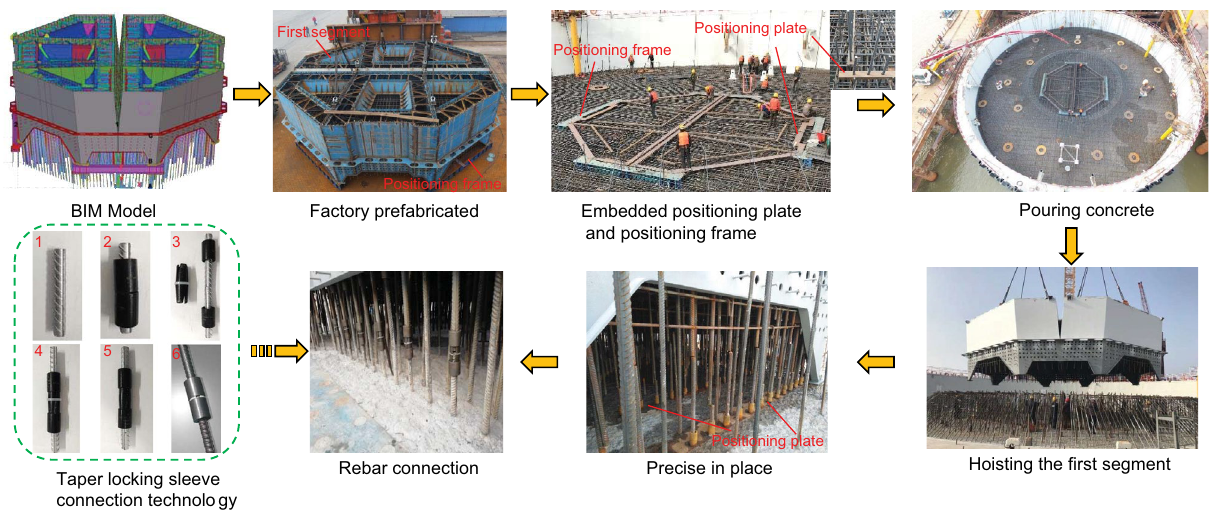
Figure 15. Precise positioning technology for the first segment.